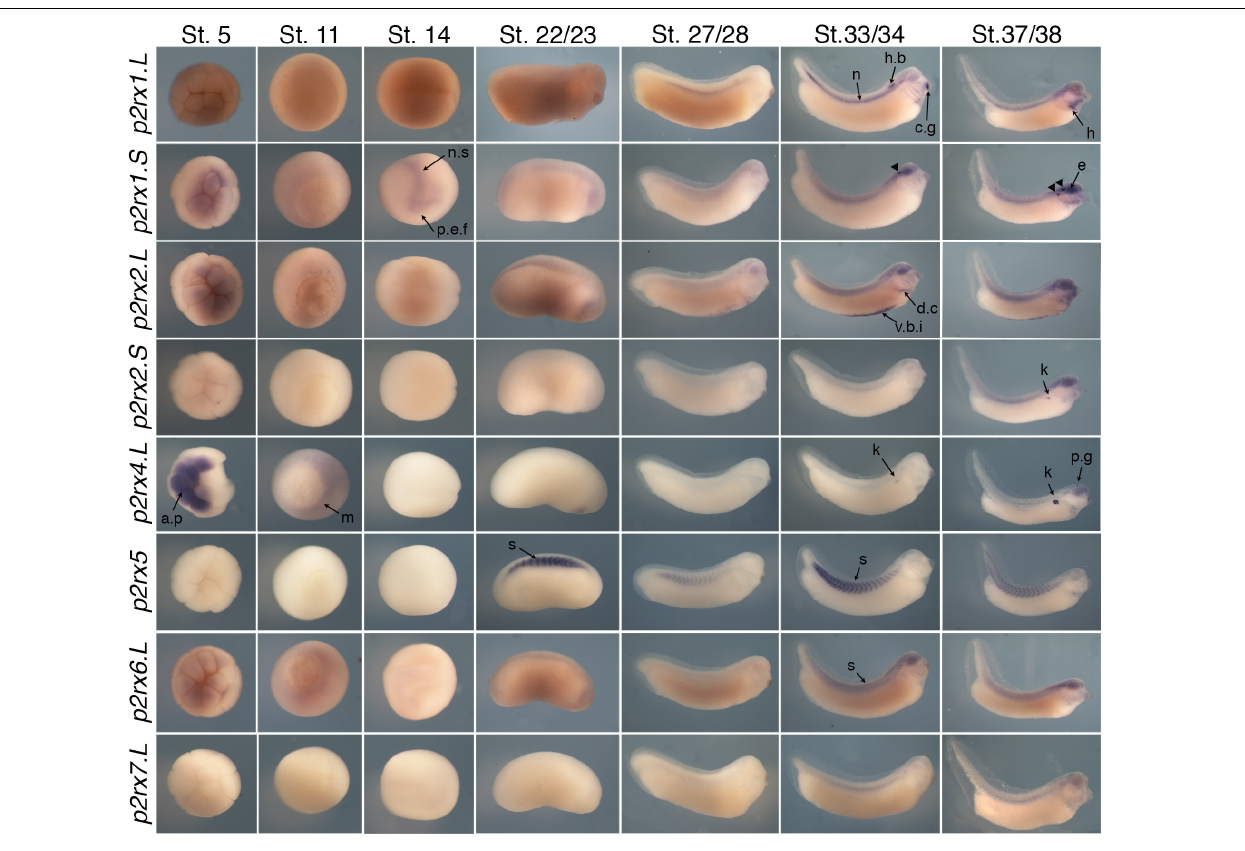
FIGURE 3 | Comparative spatial expression profile of p2rx genes during embryogenesis. Whole-mount in situ hybridization with specific DIG-labeled antisense RNA probes was performed on embryos from stages (St.) 5 to 37/38. Representative embryos were photographed at the magnification X20 for stages 5, 11, and 14 and X16 for later stages. Stage 5: animal pole view, stage 11: vegetal pole view, stage 14: dorsal view except for p2rx1.S (anterior view), later stages: lateral views, with dorsal is up and anterior is right. The arrowheads indicate the staining in the neurogenic placodes and peripheral nervous system detailed in Figure 5 . a.p, animal pole; c.g, cement gland; d.c, duct of Cuvier; e, eye; h, heart; h.b, hindbrain; k, kidney; m, mesoderm; n, notochord; n.s, nervous system; p.e.f, presumptive eye field; p.g, pineal gland; s, somite; t.n, trigeminal nerve; v.b.i, ventral blood